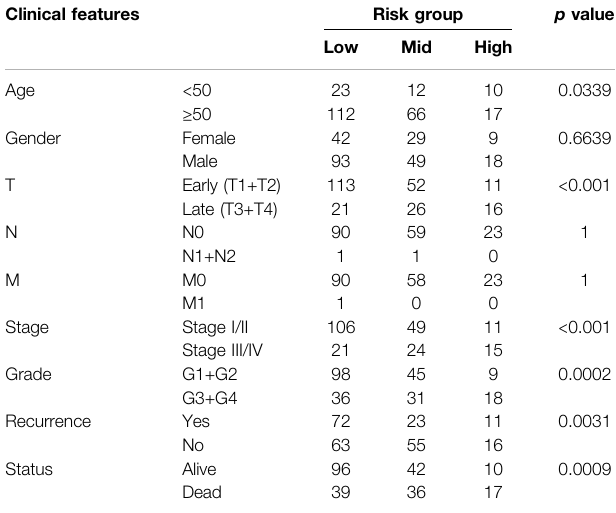
TABLE 2 | Correlation among risk groups with clinical features in training set. Clinical